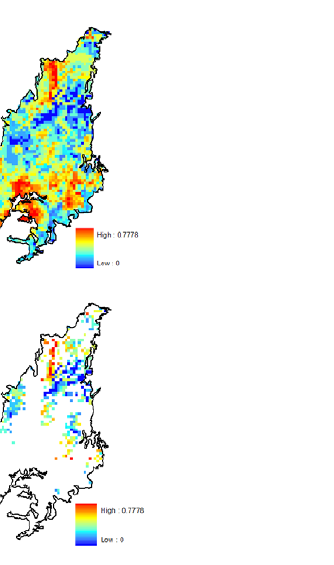
Figure 5. Consensus map of marsupial species richness in the Cerrado Biodiversity Hotspot for current and future climatic conditions, and mean turnover forecasted by model projections. Maps show patterns expected for the whole domain, no habitat filtering (a–c), and with habitat filtering (d–e). Habitat filtering followed the predictions of a spatial model of land conversion for the Cerrado, developed in this study. See text for further